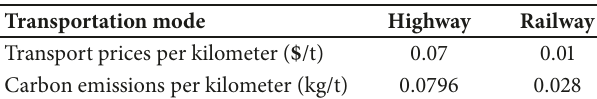
Table 2: Related parameters of two transport